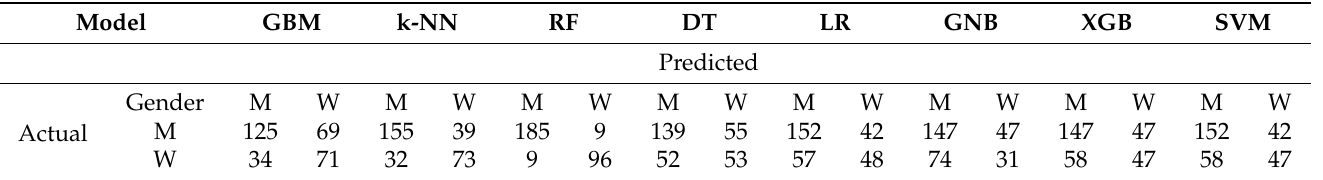
Table 14. Gender classifier’s CMs.